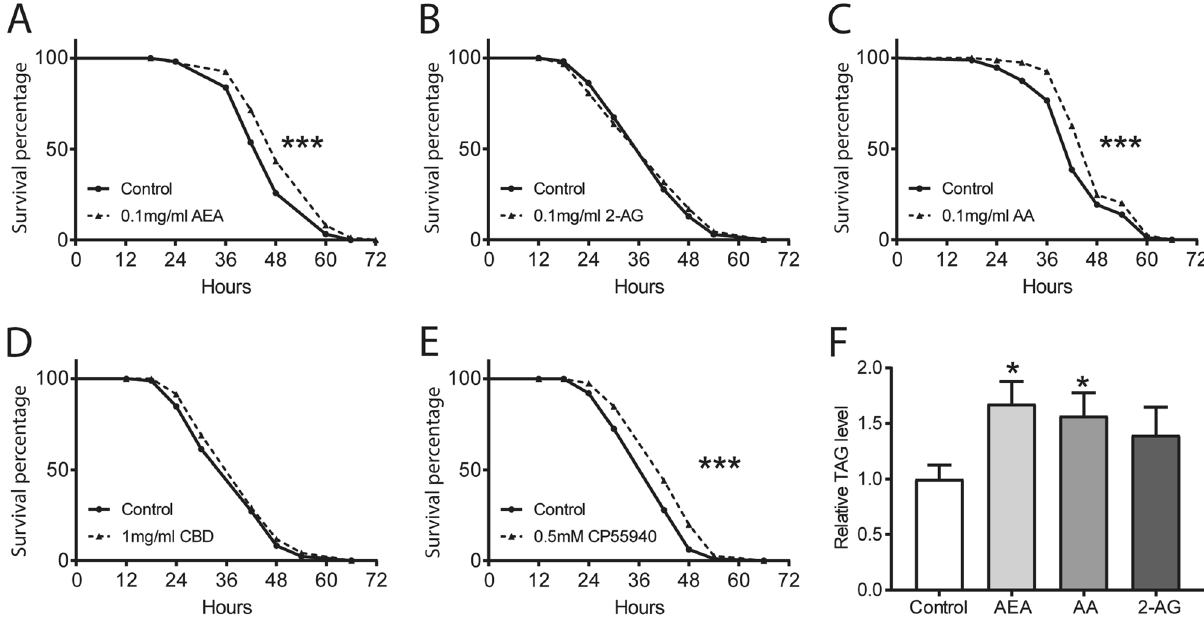
Figure 7. AEA and AA protects flies from starvation stress and inhibits lipid metabolism. ( A – E ) Following two days of cannabinoid treatment, the percentage of the surviving flies was quantified to assess the resistance to starvation. Pre-treatment with 0.1 mg/ml AEA ( A ), 0.1 mg/ml AA ( C ), and 0.5 mM CP55940 ( E ) significantly enhanced the starvation resistance, while no effect was detected with 0.1 mg/ml 2-AG ( B ) and 1 mg/ml CBD ( D ) (n = 9–14 vials/group). ( F ) Quantification of the triacylglycerol (TAG) levels in the flies revealed a significant increase with 0.1 mg/ml AEA or 0.1 mg/ml AA pre-treatment following 18 h starvation as compared to the control group (n = 7–10 vials/group). Both one-sample t test and Log-rank (Mantel-Cox) test were used to determine the significant differences. * p < 0.05 and *** p <